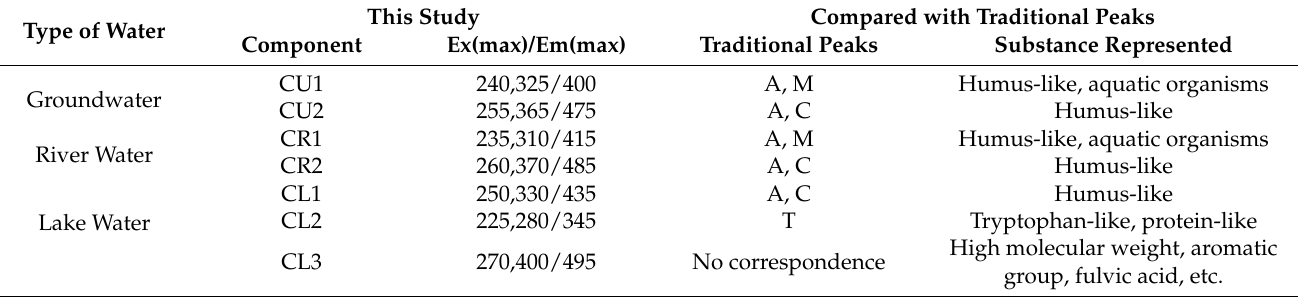
Table 1. Comparison of peaks for each fluorescence component in different waters.